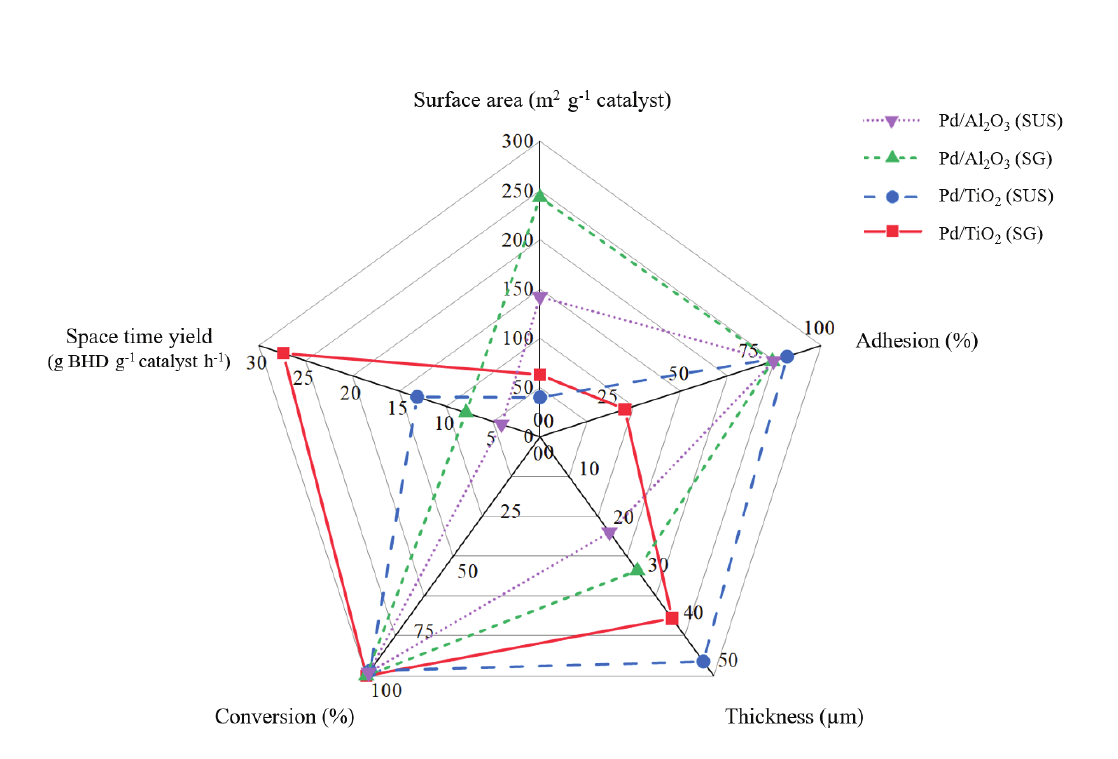
Fig. 9 – Spider diagram of Pd/Al